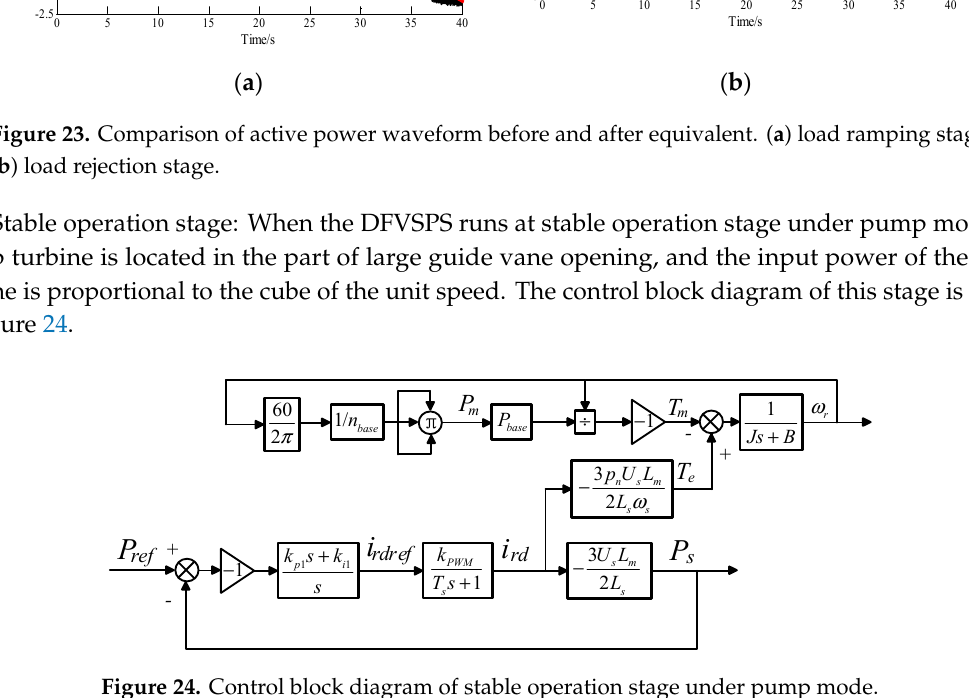
Figure 25. Comparison of active power waveform before and after equivalent during stable operation stage.